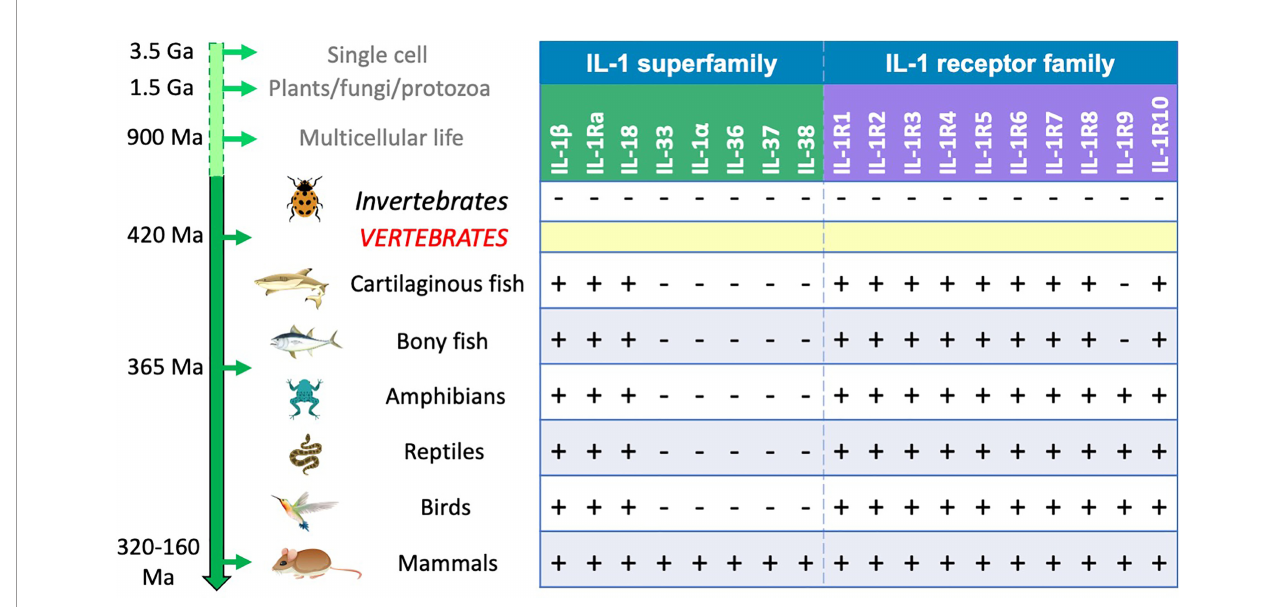
FIGURE 1 | IL-1 and IL-1R family molecules in vertebrates. No IL-1-like homologous sequences have been identi fi ed in invertebrates, whereas numerous orthologues of IL-1R family genes were identi fi ed. This places the appearance of proto-IL-1 genes at the same time as the appearance of the vertebrate subphylum around 420 million years ago (48). The various IL-1R genes are present in all vertebrates, from cartilaginous fi sh to mammals, except for IL-1RAPL1 , which only appeared after separation of bony fi sh and Tetrapoda clades about 365 million years ago, most likely from duplication of the IL1RAPL2 gene. All vertebrates possess the genes for IL-1 b , IL-1Ra and IL-18, whereas all the other IL-1 genes only appeared in mammals; genes encoding IL-1 a , the IL-36 group, IL-37 and IL-38 are likely derived from IL-1 b gene duplication, while the gene for IL-33 has independently evolved. Please note that the receptor genes were present in evolution long before the appearance of their ligands. Minus and plus signs indicate gene absence or presence.